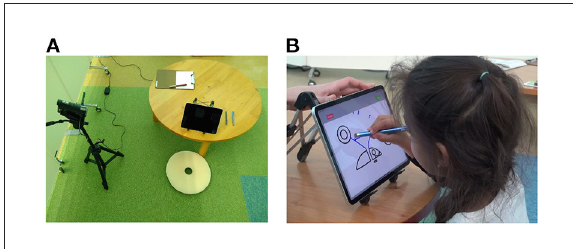
FIGURE2 Setup of the experiment in the museum. (A) View on the tablet PC used for drawing, the child sits in front, the experimenter on the left side of the table. (B) A child drawing on one stimulus.